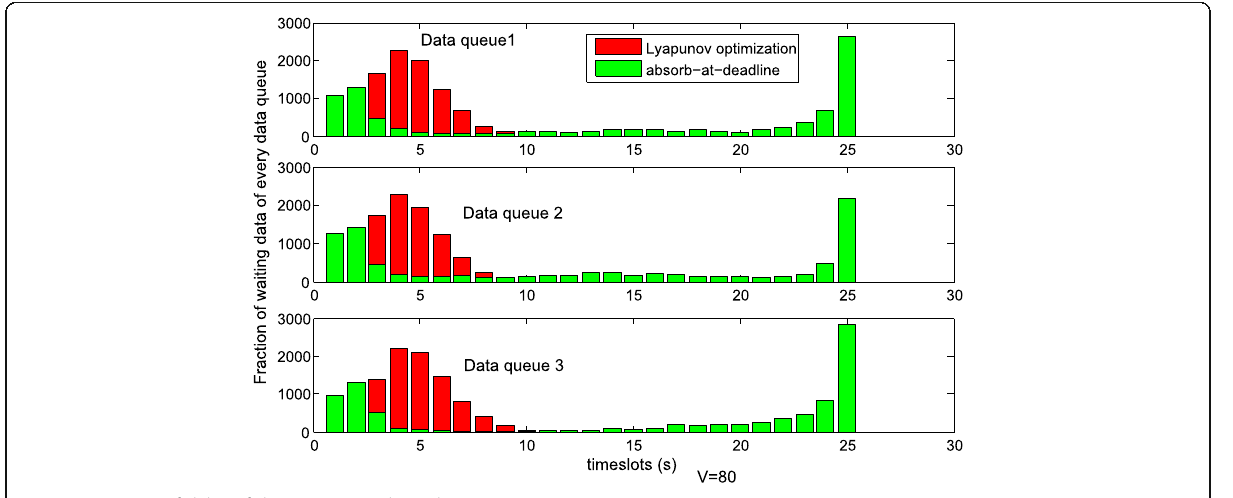
Fig. 6 Histogram of delay of data waiting in three data queues